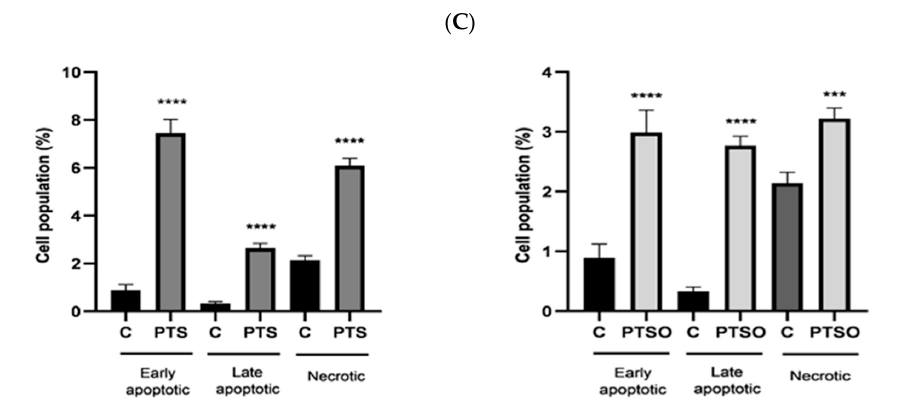
Figure 4. Analysis of apoptosis in MCF-7 ( A ) and T-84 ( B ) cell viability with and without PTS or PTSO for 48 h, revealed with annexin V-FITC/PI staining by cytometry. The graphics show the percentages of early apoptotic, late apoptotic, and necrotic cells after induction with PTS and PTSO at a concentration of IC50 in MCF-7 cells. ( C ) Histograms of MCF-7 and T-84 cells. Control = untreated control cells. The experiment was repeated independently three times yielding similar results. **** = p < 0.0001; *** = p < 0.001.